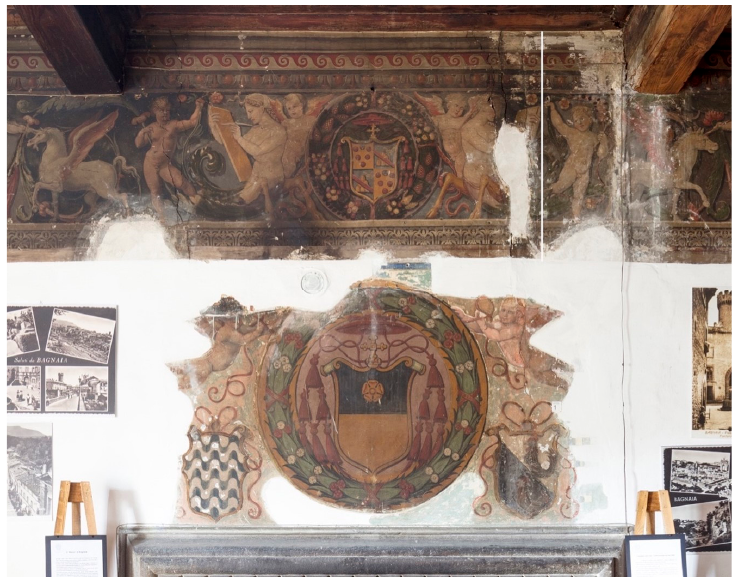
Figure 1. The wall paintings before the restoration (photograph by Gaetano Alfano).